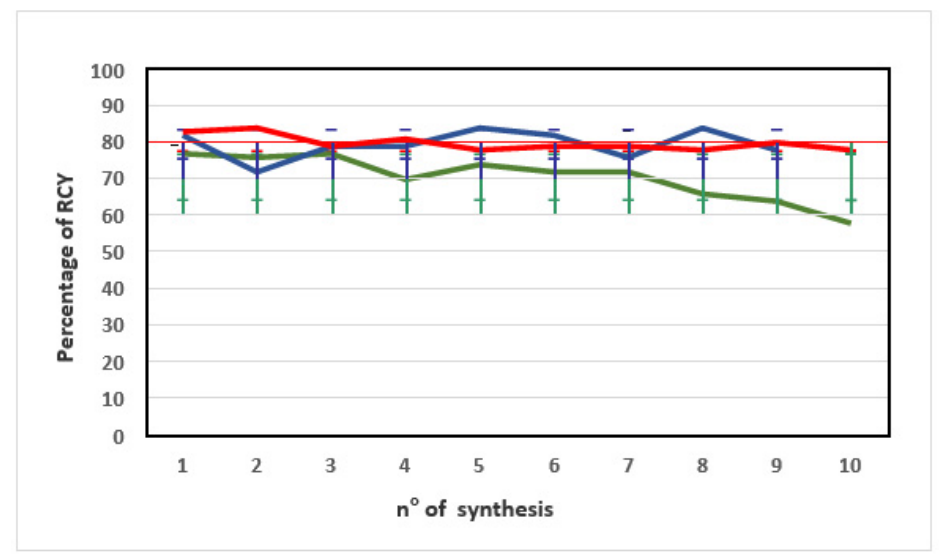
Figure 2. Trend of the percentage of RCY obtained from [ 68 Ga]Ga-PSMA-11 radiosyntheses per- formed using a PSMA-11 precursor solution from methods A (green line), B (blue line), and C (red line). The error bars show standard deviations (SD). Table 2. Comparison of % RCY data obtained with Method C utilizing different lots of PSMA-11 material and a germanium-68/gallium-68 generator (1.85 GBq) at the end of shelf life (left data), at the start of shelf life (central data), and in the middle of shelf life (right data). Method C